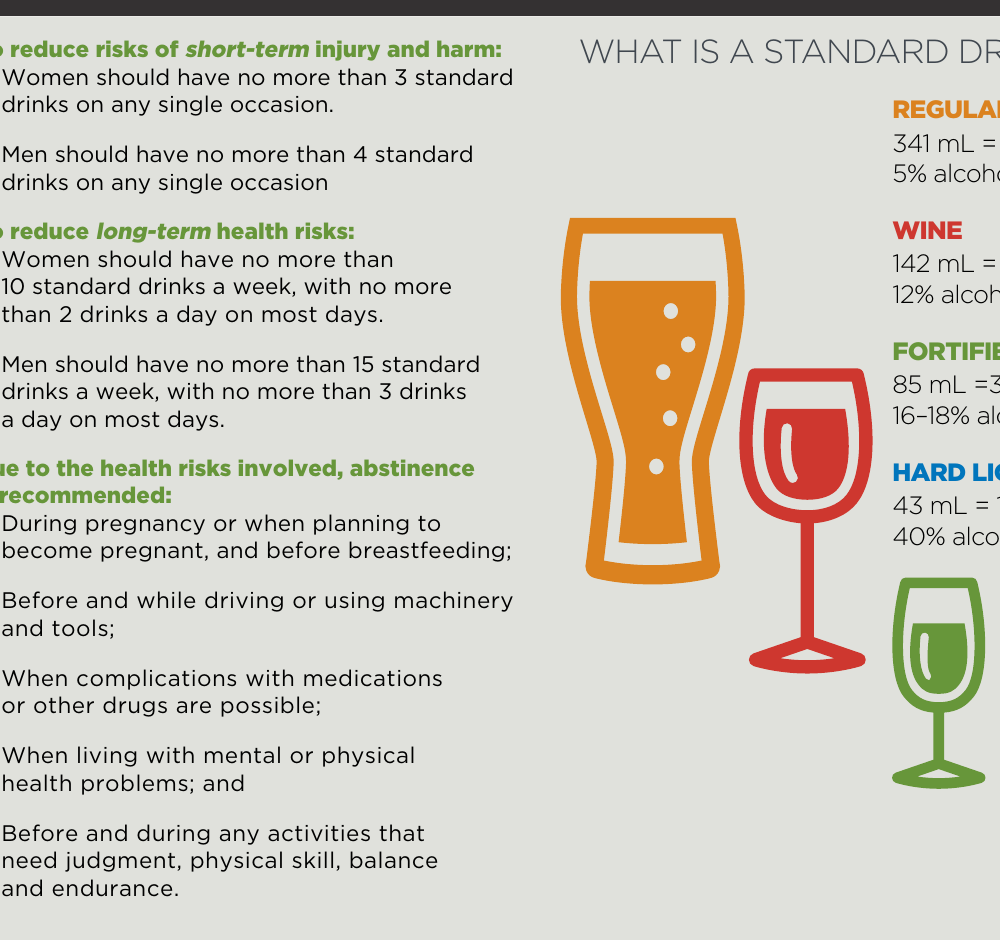
From Brain to Behaviour As a psychoactive drug, alcohol acts on the brain, leading to changes in behaviour. Alcohol’s effects are dose-dependent and